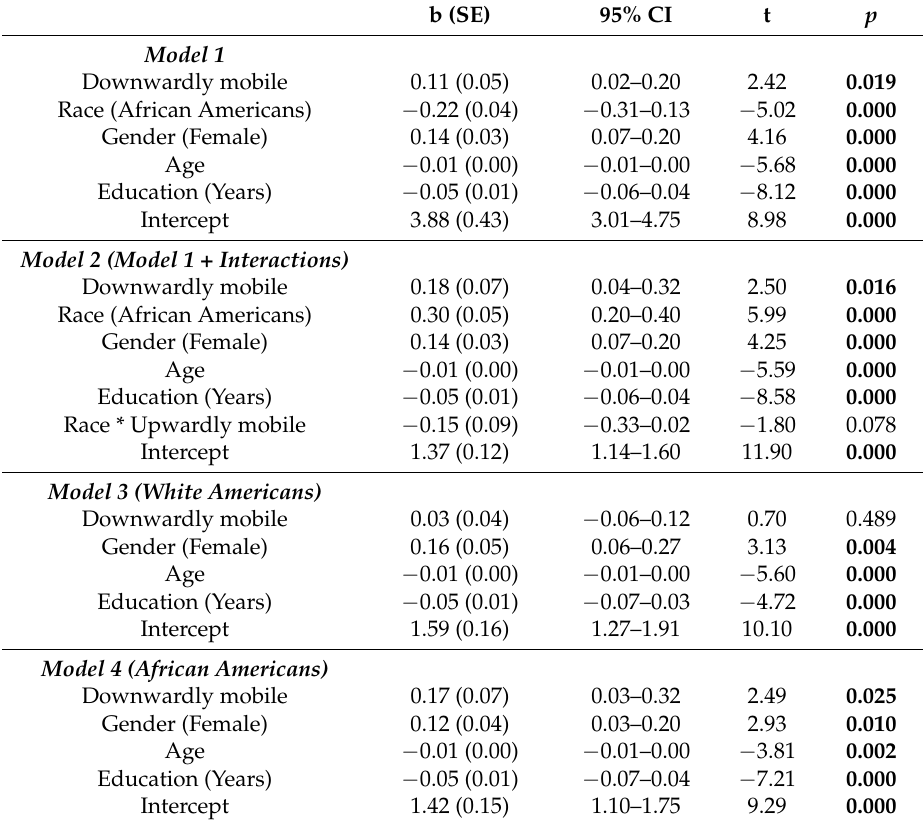
Table 3. Linear regressions between downward social mobility and